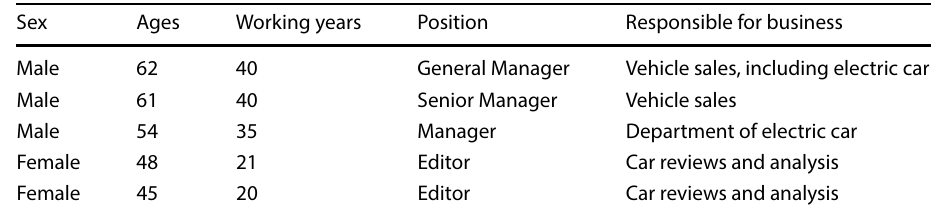
Table 1 The detailed description of the interviewees for EGM